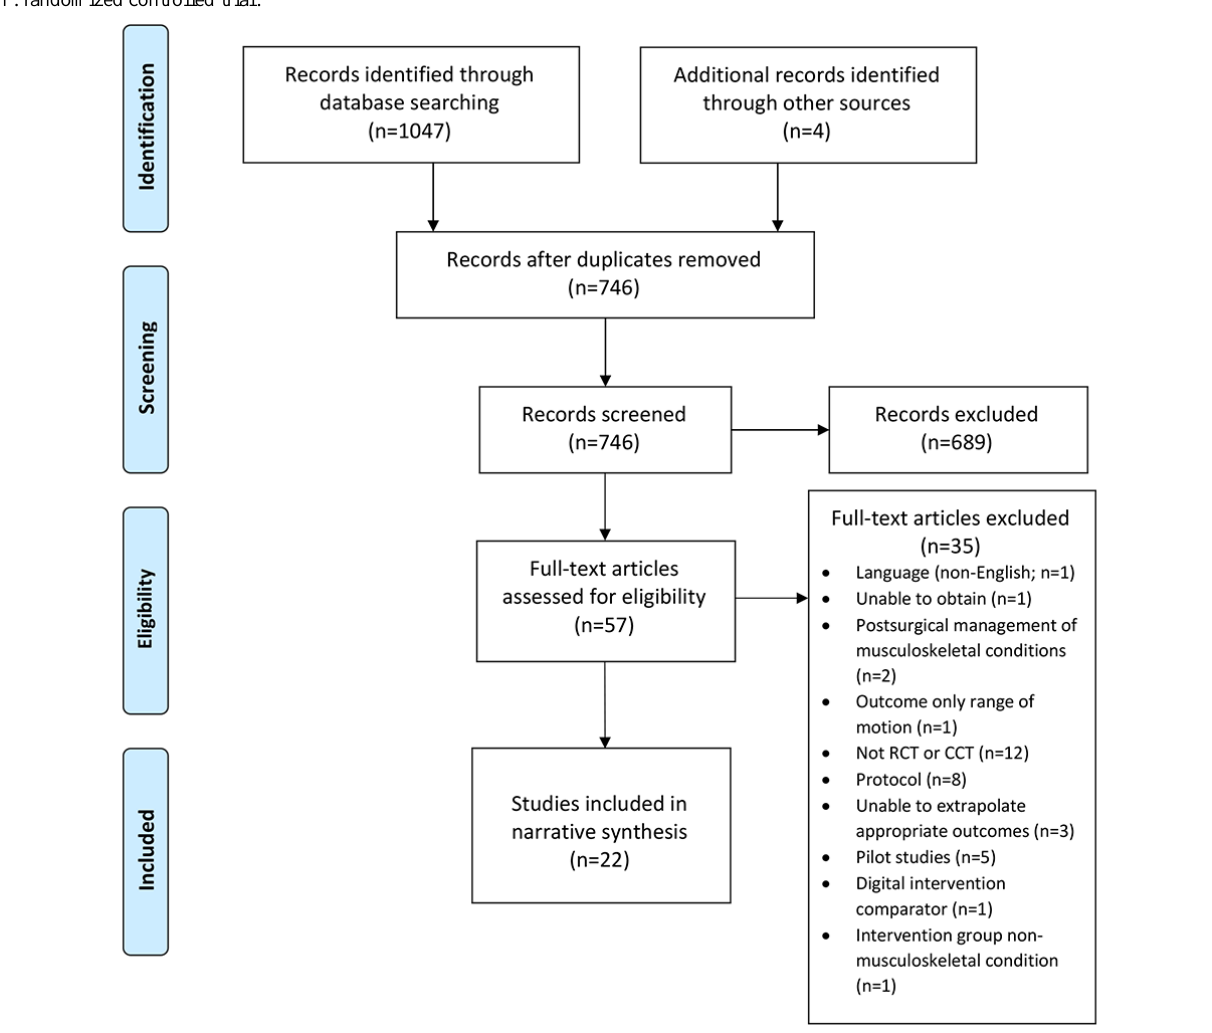
Figure 1. Preferred Reporting Items for Systematic Reviews and Meta-Analyses flow diagram indicating search strategy. CCT: controlled clinical trial; RCT: randomized controlled